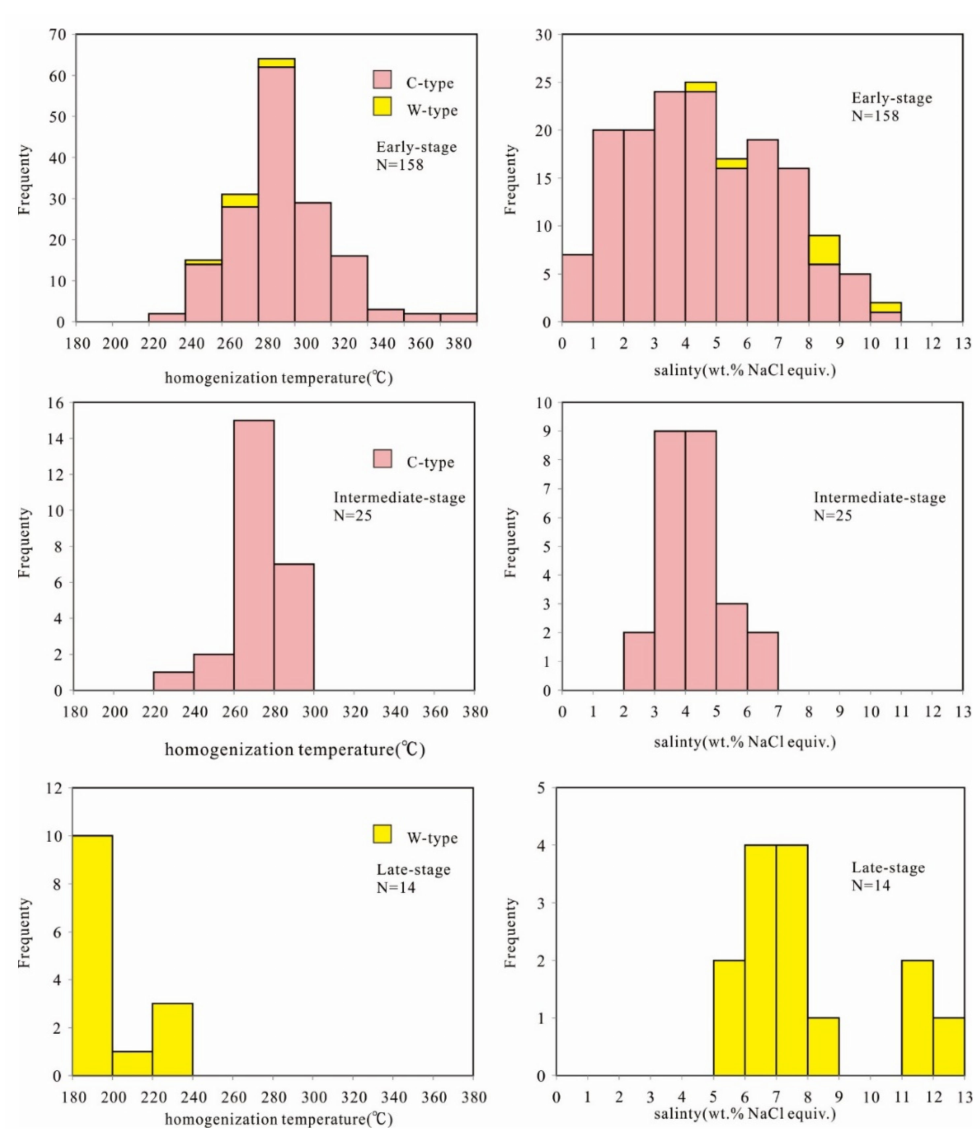
Figure 6. Histograms of homogenization temperatures and the salinities of fluid inclusions.